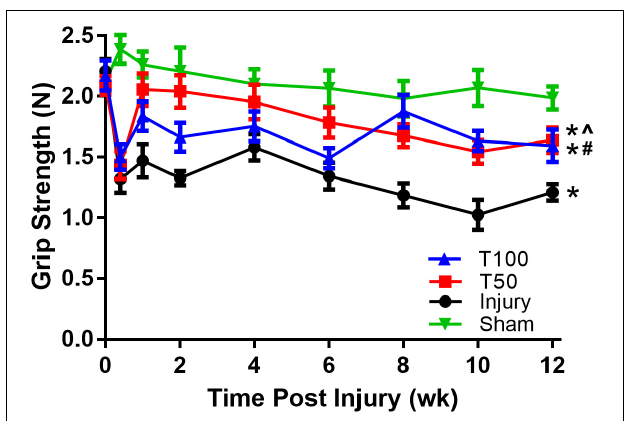
FIGURE 2 | Grip strength test. The grip strength of the injury, T50, and T100 groups was significantly lower than that of the sham group. The overall recovery of the grip strength of the T50 group and the T100 group was significantly better than that of the injury group. * P < 0.05, comparison between each group and the sham operation group; # P < 0.05, comparison between T50 group and injury group; ∧ P < 0.05, comparison between T100 group and injury group.